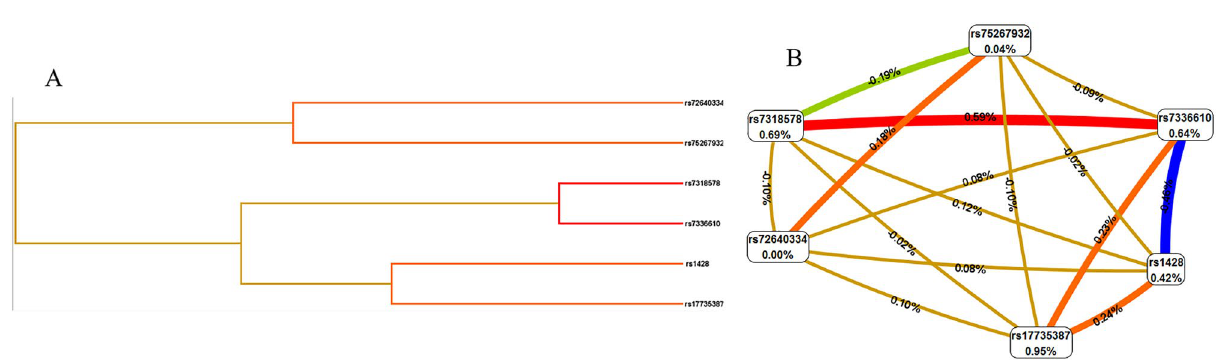
Figure 1. MDR analysis results. MDR -3.0.2 software: http:// sourc eforge. net/ proje cts/ mdr/. Dendogram ( A ) and Fruchterman Rheingold plot ( B ) of the interactions of MIR17HG SNPs rs75267932, rs72640334, rs7336610, rs7318578, rs17735387 and rs1428 for HAPE risk. Shorter connections among nodes indicate stronger redundant interactions. Negative percent entropy indicates